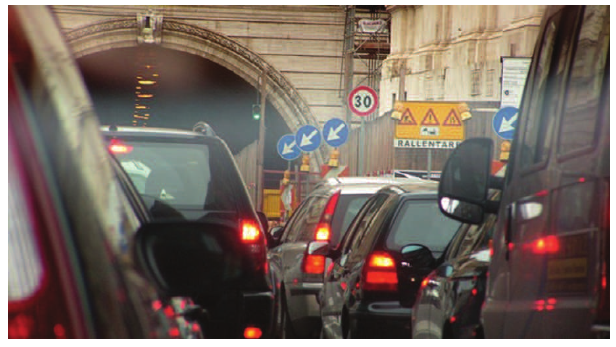
Fig. 1. Air pollution in urban agglomerations